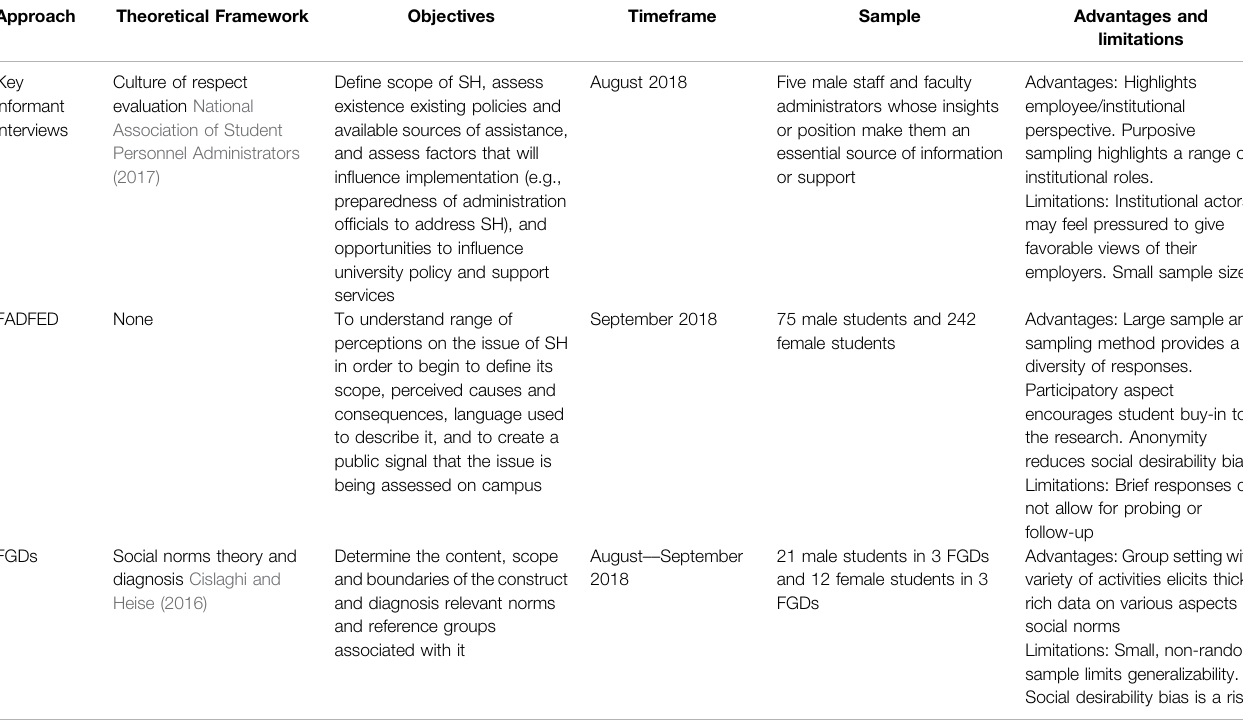
TABLE 1 | Phases of qualitative data